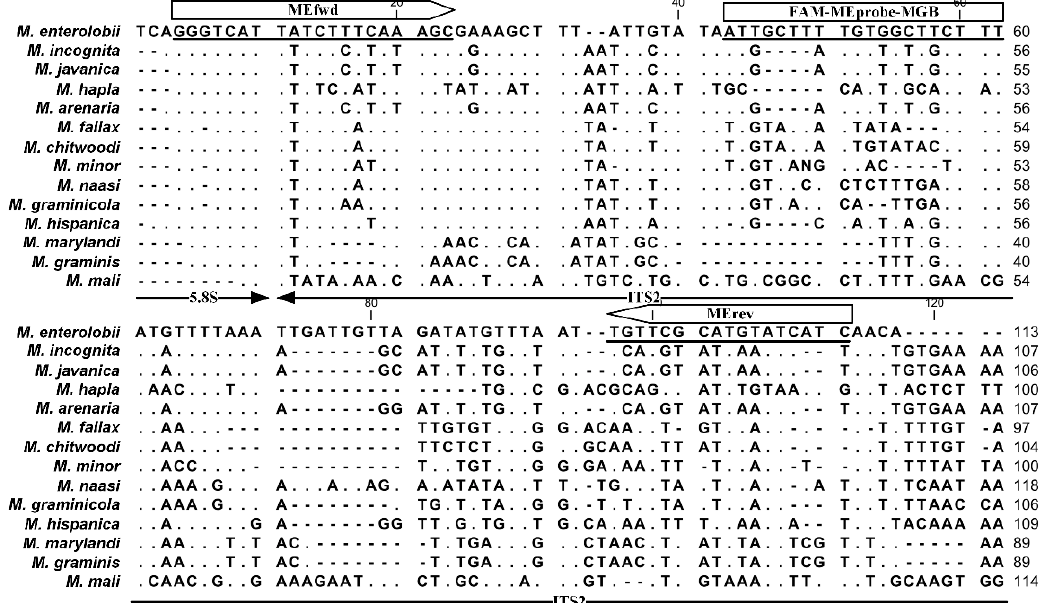
Figure 1. Designed primers and Taqman probe-targeted ITS2 sequence of M. enterolobii in this study. The dots and dashes indicate conserved nucleotides and gaps in the sequences, respectively.